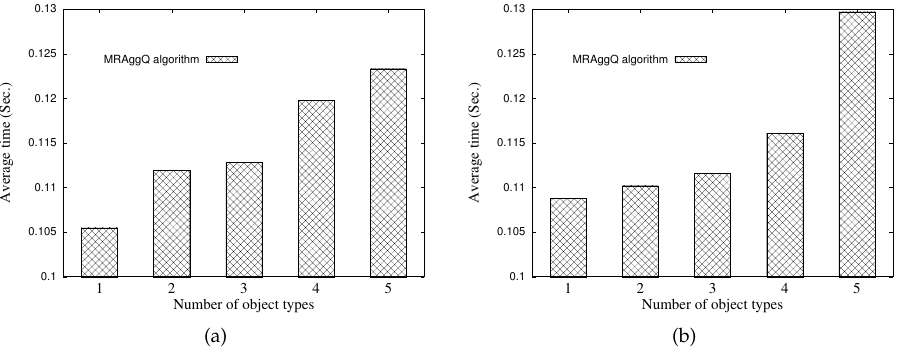
Figure 10. Effect of the number of object types. ( a ) Uniform dataset; ( b ) Manchester